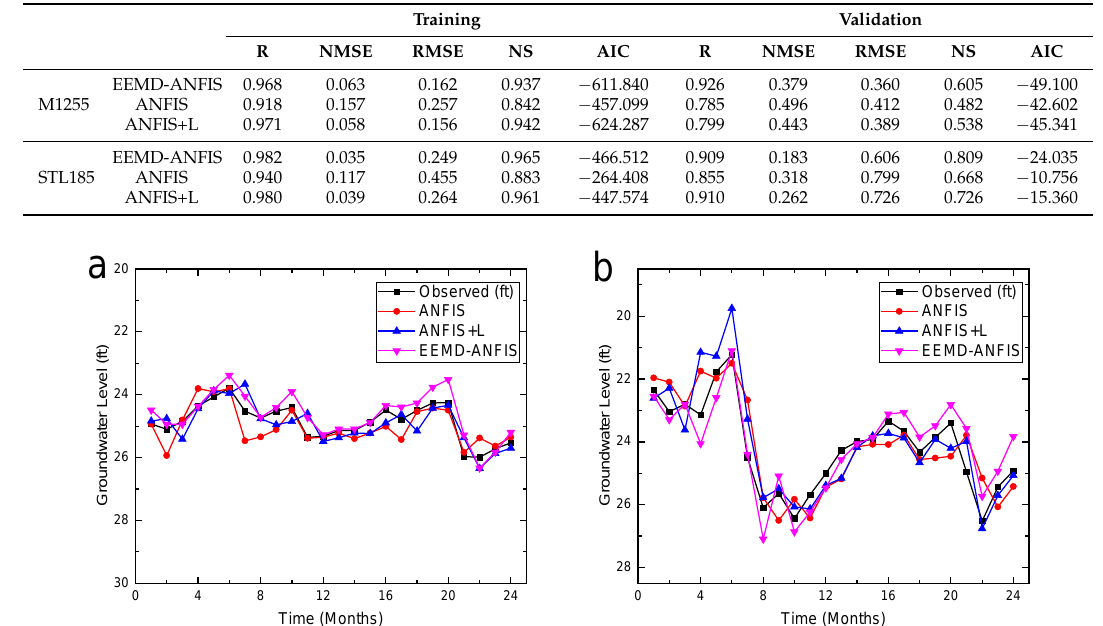
Figure 13. Observed and predicted groundwater levels using ANFIS, ANFIS+L and EEMD-ANFIS ( a ) M1255 ( b ) STL185.